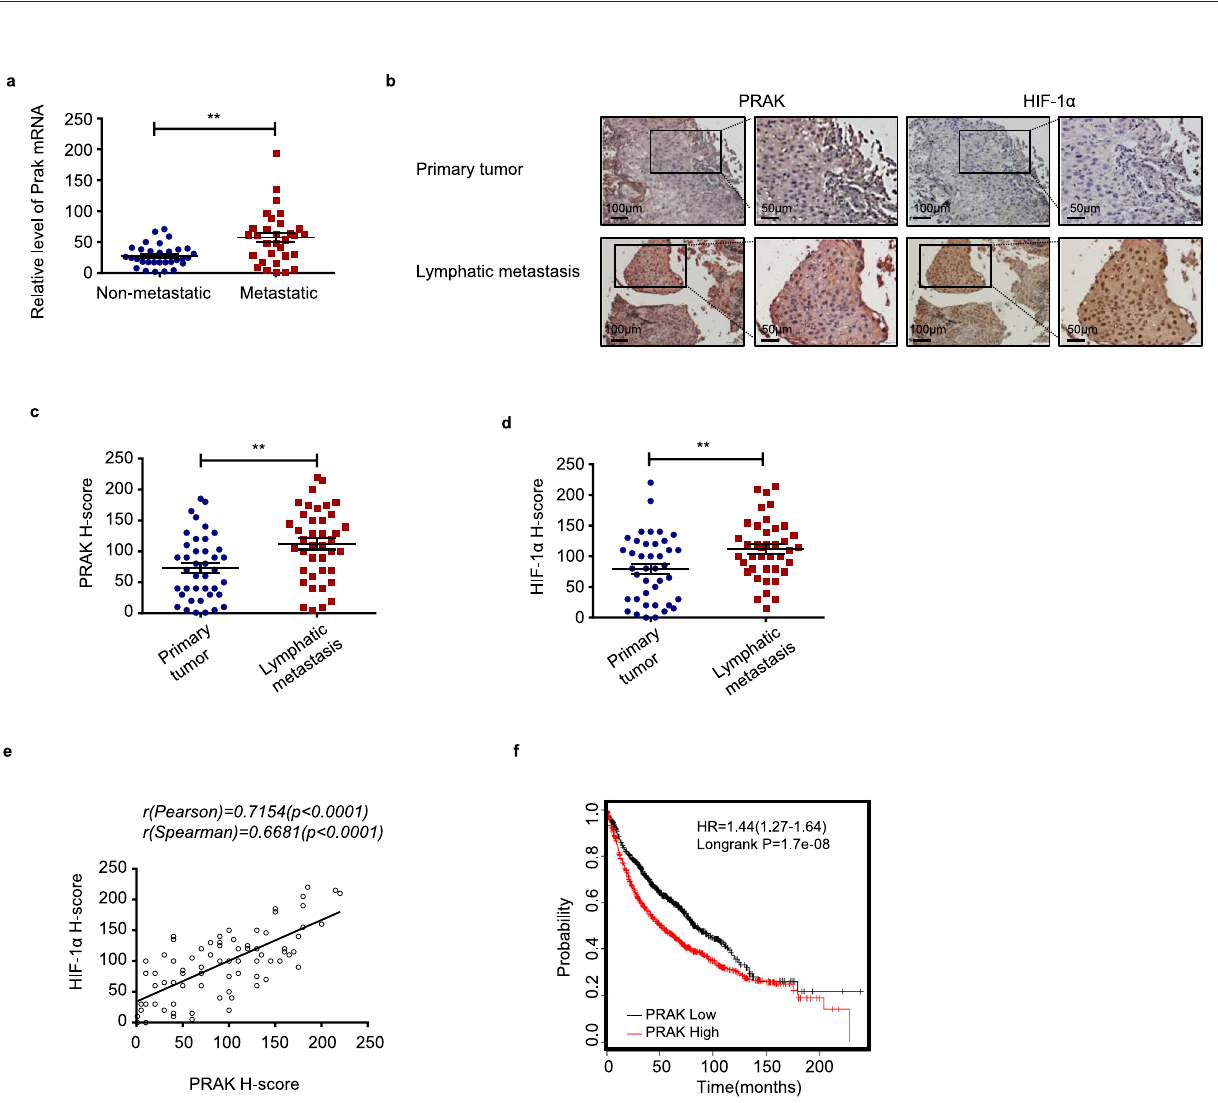
Fig. 5 PRAK promotes HIF-1 α translation by regulating mTORC1 activity. a HIF-1 α mRNA levels in Prak + / + and Prak − / − B16 cells (left) and in B16 cells treated with the PRAK inhibitor (right) as measured by real-time RT-PCR. An agarose gel of the PCR products is shown on the Left. b HIF-1 α protein levels in parent, Prak − / − and GLPG0259-treated B16 cells in the absence or presence of MG132 as determined by Western blotting. Tubulin served as a loading control. c B16 cells were cultured in the presence of MG132 for 10 h. HIF-1 α was precipitated from the lysate and the blot was probed with anti-ubiquitin antibodies. d B16 cells were cultured in the presence of CoCl 2 with the addition of 500 μ Ci of [ 35 S]-L-methionine and [ 35 S]-L-cysteine for 6 h. Immunoprecipitation was performed with antibodies against HIF-1 α or tubulin or with control IgG. Newly synthesized proteins of the expected size were detected by autoradiography. e Cell lysate was prepared from control, Prak knockout, and inhibitor-treated B16 cells. The blot was probed with anti- phospho- or total mTOR, S6K1 and 4EBP1. Tubulin served as a loading control. f , g Prak + / + and Prak − / − B16 cells were cultured with or without the mTORC1 agonist MHY1485 (1 μ M for 12 h). HIF-1 α , MMP2, and MMP9 expression was detected by immunoblotting ( f ). The invasive capacity of these cells was analyzed using Matrigel assay ( g ). Each experiment was repeated at least three times with similar results. ns no signi fi cant, ** p < 0.01. p -value was determined by a two-tailed, unpaired t -test.